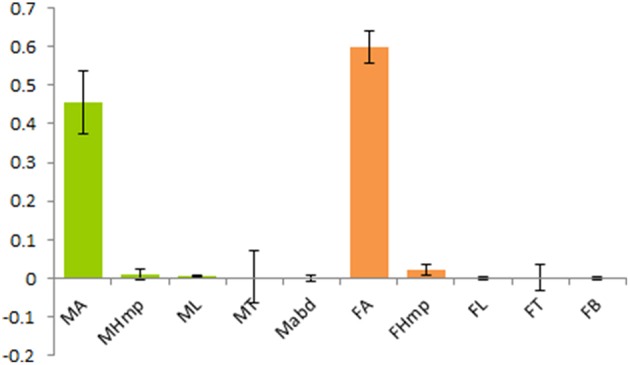
Relative transcript levels of McinOBP4 of both sexes. Expression level of M. cingulum odorant binding protein 4 (McinOBP4) in different tissues of adult male and females measured by qPCR. cDNAs were amplified with specific primers from antennae, heads (without antennae), thoraxes, abdomens, legs, and abdomen.